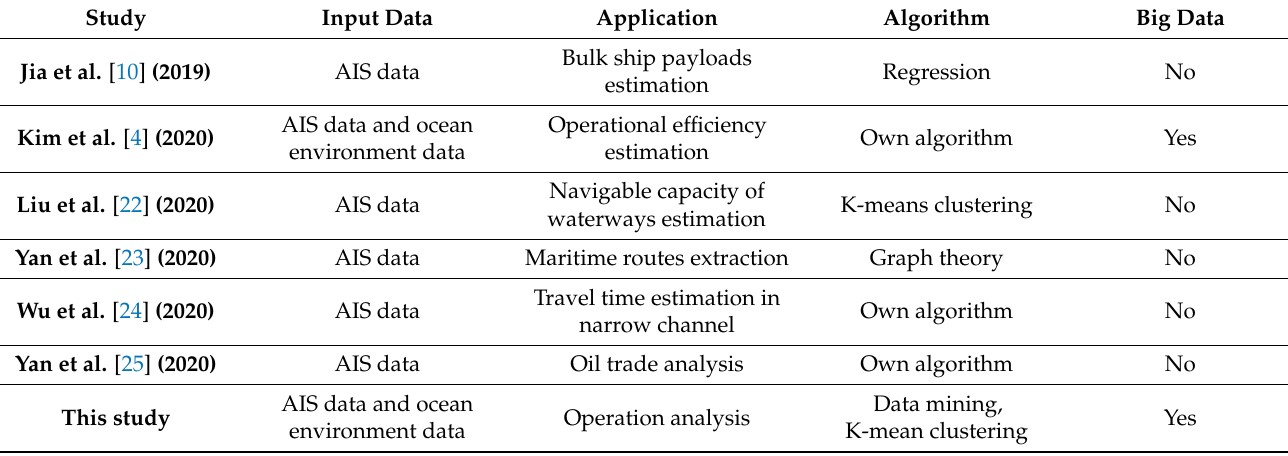
Table 1. Summary of the related works and this